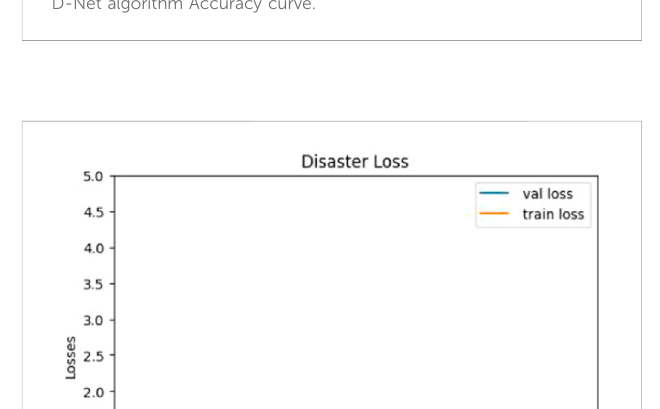
FIGURE 5 D-Net algorithm Accuracy curve.